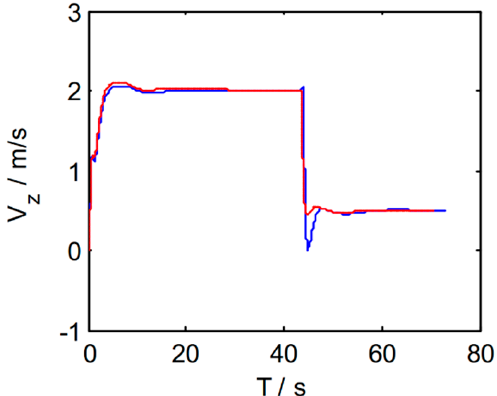
Figure 12. Landing speed in windward conditions.